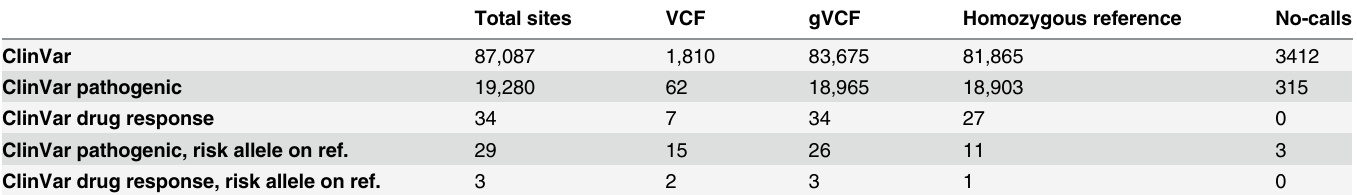
Table 4. Genotyping of known SNPs from ClinVar using the VCF and gVCF file formats and the number of homozygous reference sites and no- calls based on WGS data.